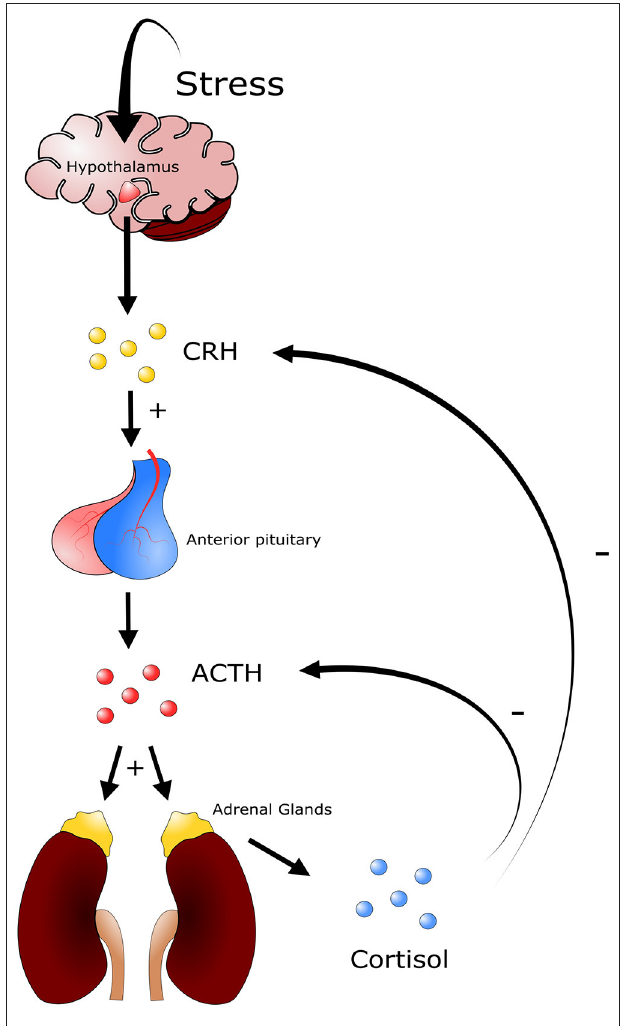
FIGURE 2 | Depiction of the hypothalamic pituitary adrenal axis. Different stressors will induce a response from the hypothalamus triggering the release of corticotrophin releasing-hormone (CRH). CRH in turn stimulates the secretion of adrenocorticotropic hormone (ACTH) from corticotroph cells in the anterior pituitary gland. ACTH is released into circulation and induces the secretion of glucocorticoids from the zona fasciculata and zona reticularis of the adrenal gland. Glucocorticoids such as cortisol (cattle) and corticosterone (mice) trigger a multitude of physiological responses throughout the animal. A negative feedback system is in place to regulate the production of glucocorticoids, where high levels of cortisol or corticosterone in blood inhibit the production of ACTH and